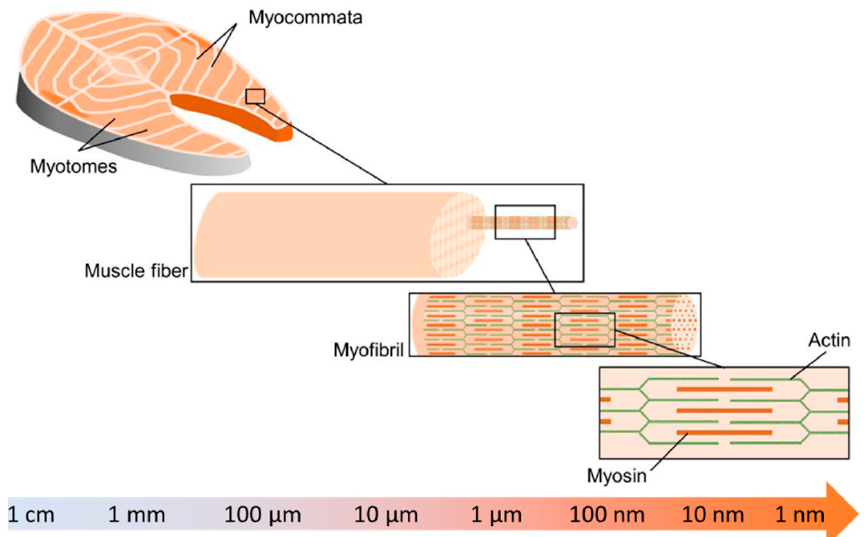
Figure 2. A schematic diagram indicating the hierarchical structures of fish muscle structure (Adapted from Kazir and others with permission) [29].